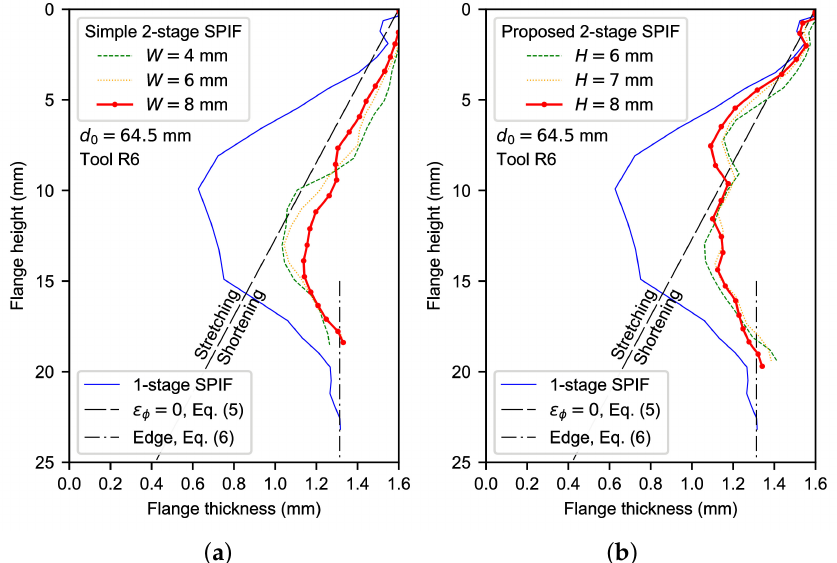
Figure 11. Flange thickness distribution by two-stage SPIF: ( a ) straight section and ( b ) proposed